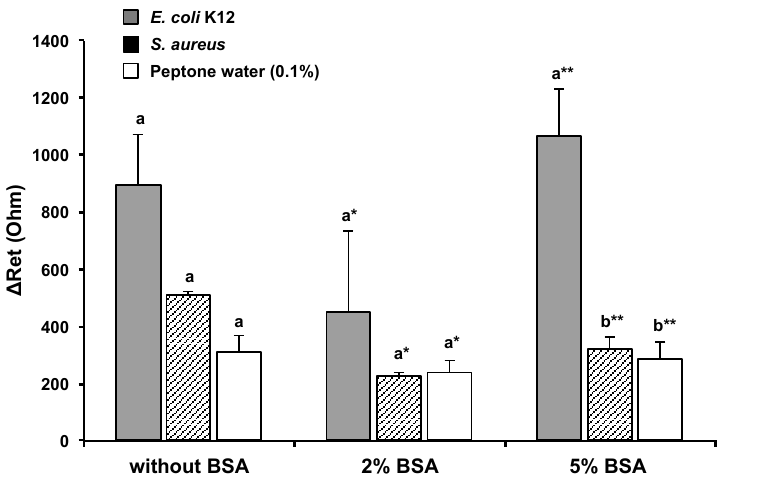
Figure 4. Effect of BSA on nonspecific binding reduction * and ** Δ R et values from different BSA treatments were analyzed separately. Error bars indicate the standard deviation of the mean. Different letters (a and b) in the figure indicate significant differences ( p ≤ 0.05).